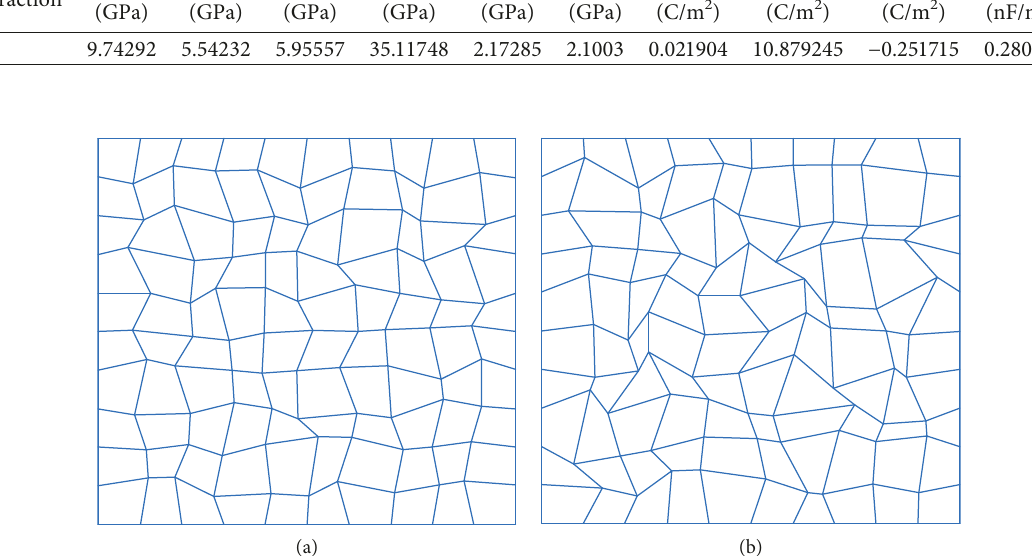
Figure 6: Typical irregular elements with irregularity factor α